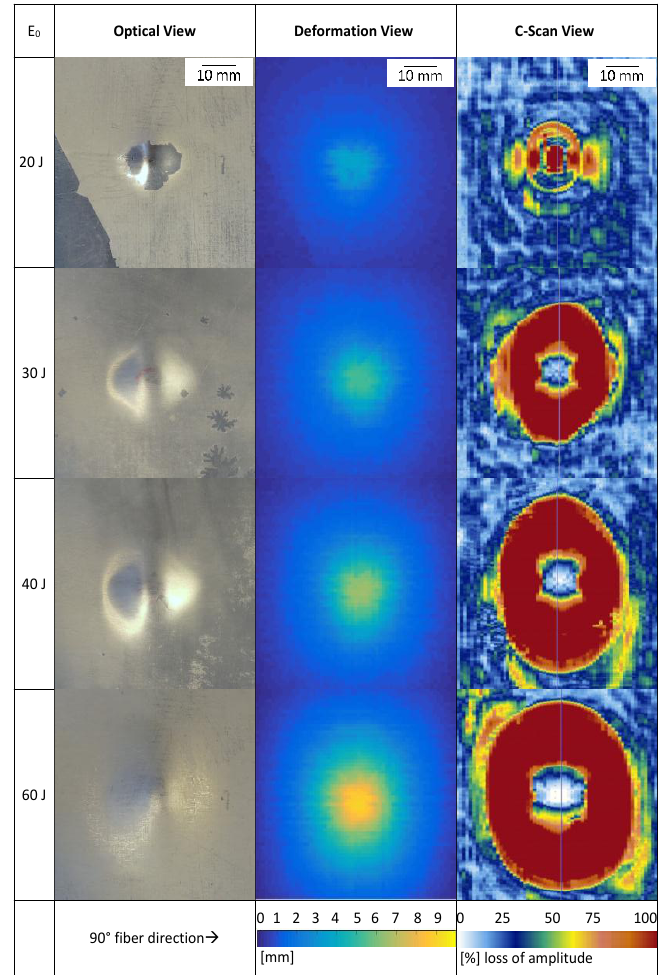
Figure 6. Optical ( left ), deformation ( centre ) and C-Scan ( right ) views of the opposite sides of impacted FML plates.